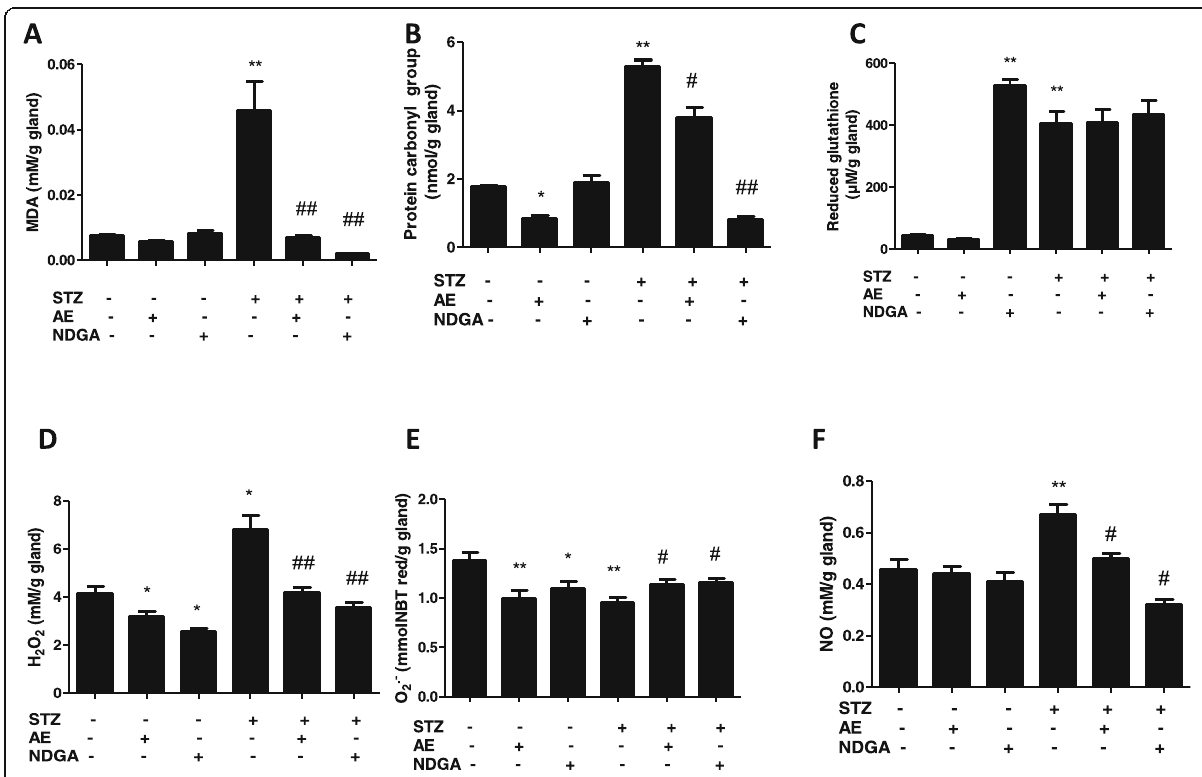
Fig. 4 Effect of AE and NDGA on streptozotocin-treated rats on lipid peroxidation ( a ), carbonyl protein groups ( b ), reduced glutathione ( c ), hydrogen peroxide ( d ), superoxide anion ( e ) and NO ( f ) in submandibular glands. Results represent Mean ± SEM of values from at least five glands. * P < 0.05; ** P < 0.01 significant differences between submandibular glands from normal control and submandibular glands from STZ-treated animals (Student ’ s t test). # P < 0.05, ## P < 0.01 significant differences between submandibular glands from STZ-treated control animals and STZ-treated glands incubated with either AE or NDGA (ANOVA + Dunnett ’ s test). AE: 500 μ g/ml, NDGA: 1.5 μ